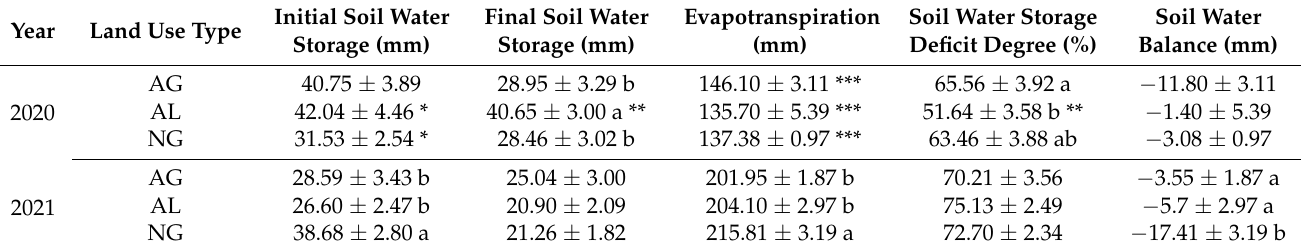
Table 2. Soil water storage, soil water balance, storage deficit degree in the 0–30 cm soil depth and evapotranspiration at different land use type in 2020 and